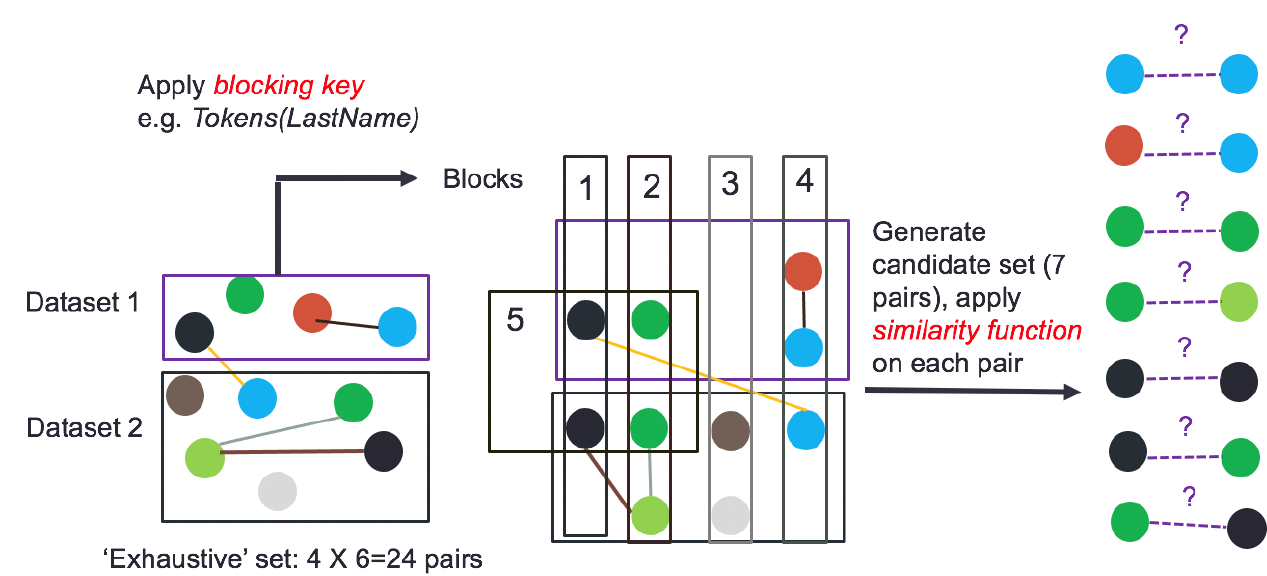
Figure 1. A basic illustration of the two-step Entity Resolution (ER) workflow on two heterogeneous datasets (shown here as graphs with nodes and relations). Brute force comparisons would require quadratic time, even given a similarity function. The blocking step uses an inexpensive function (e.g., tokenizing and indexing on the last name, assuming the nodes represent people), called a blocking key, which is similar to traditional hashing, but (in the general case) can lead to overlapping blocks. The similarity function is now only applied to pairs of entities sharing blocks, leading to seven unique entity pairs. Based on the output of the similarity function, these pairs of entities will be determined to refer to the same underlying entity (or